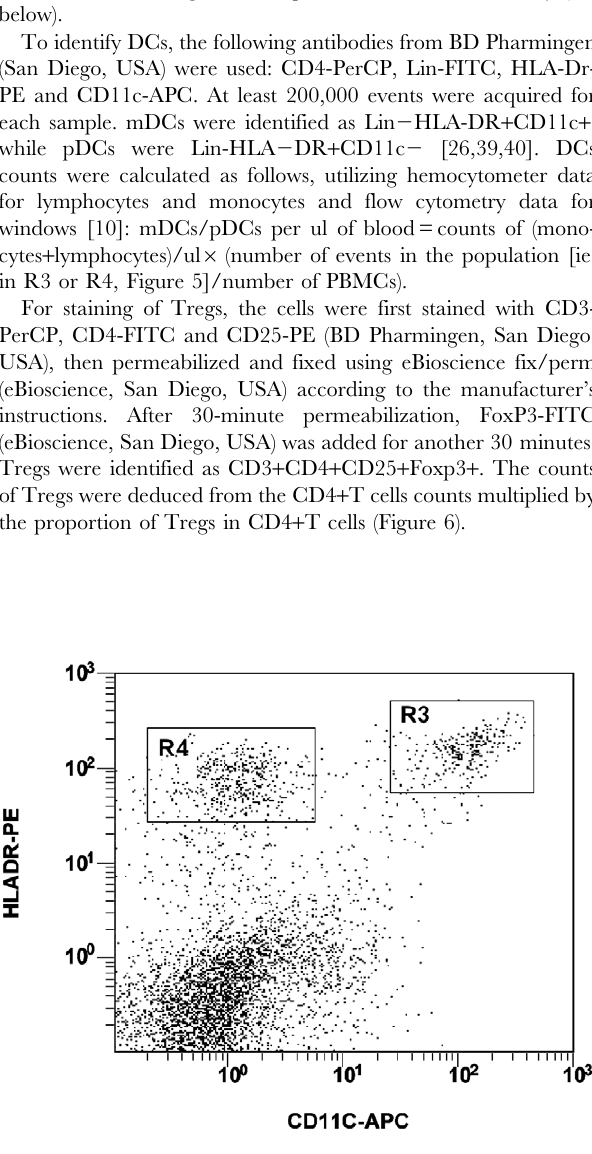
Figure 5. Rare event analysis of DC subsets by flow cytometry: mDCs (R3) and pDCs